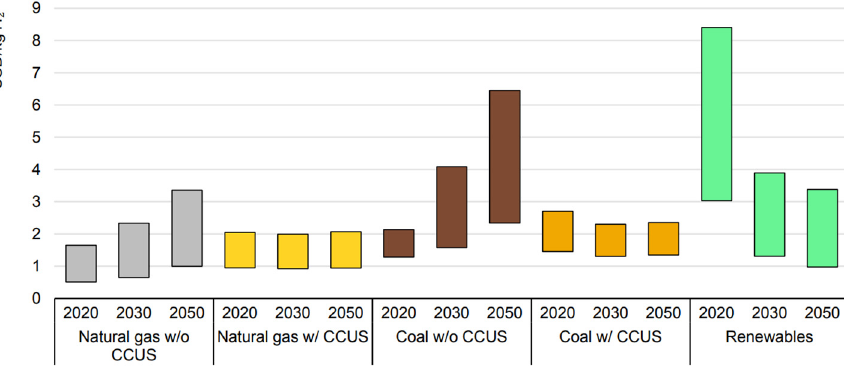
Figure 6. Comparison of hydrogen production costs with different technologies and scenarios [2].